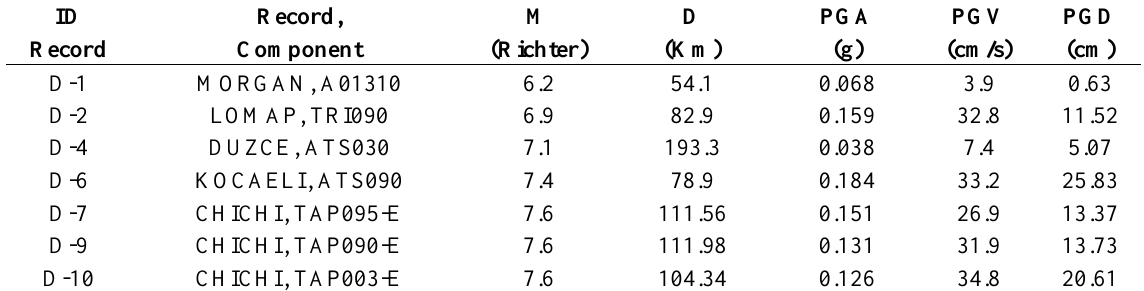
Table 7. Set of ground motion records in soil type D.